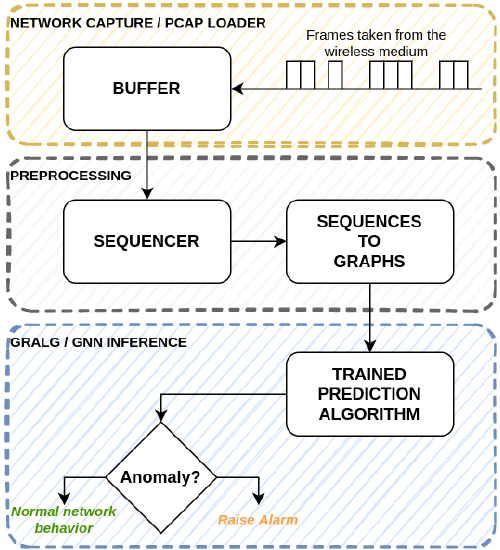
Figure 5. Processing flow of the proposed classification algorithms in test mode.